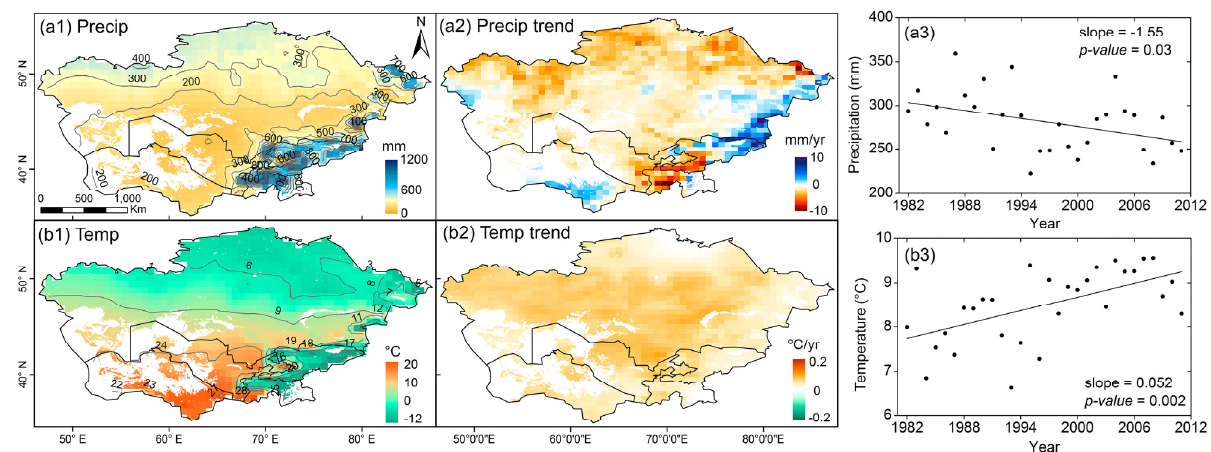
Figure 3. ( a1 , b1 ) Annual total precipitation (Precip) and annual mean temperature (Temp) for 1982–2011. ( a2 , b2 ) Annual trends. ( a3 , b3 ) Time series of the annual total precipitation and annual mean